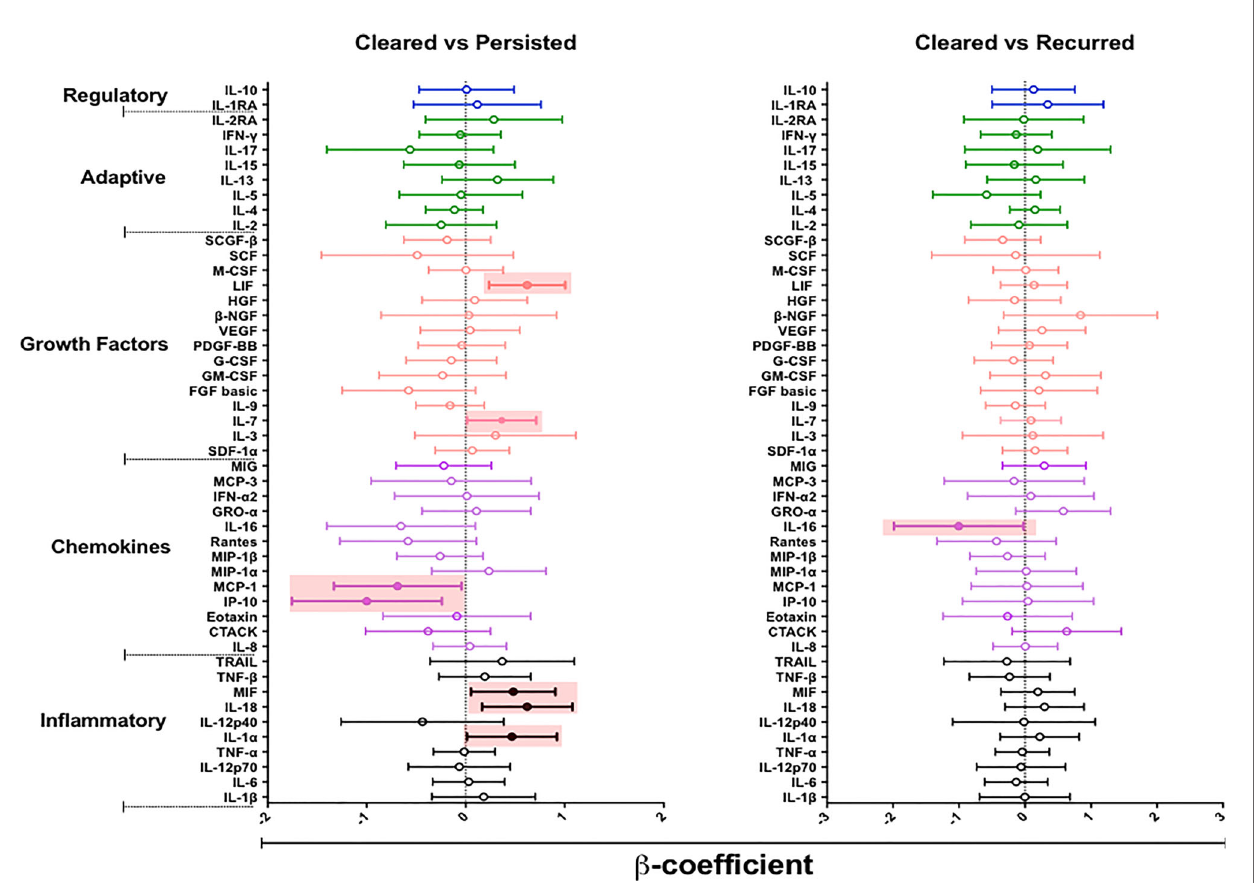
FIGURE 4 | b -coef fi cients from linear mixed models to determine the effect of persistent (n= 35) or recurrent BV (n= 9) on the cytokine milieu compared to women who cleared (n= 13) their BV. Individual associations are shown between BV status and pro-in fl ammatory cytokines (black), chemokines (purple), growth factors (orange), adaptive response cytokines (green), and regulatory cytokines (blue), with error bars depicting standard error. Shaded shapes represent signi fi cant associations, after adjusting for age, recent sexual activity, and sexually transmitted